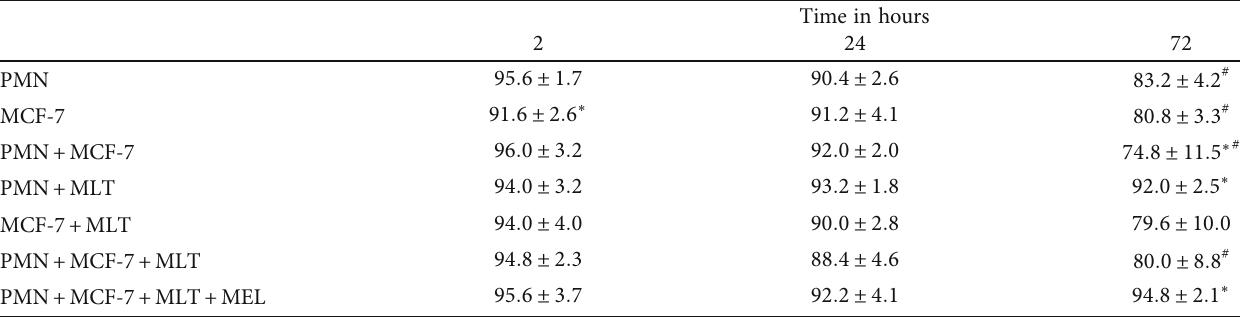
Table 1: Viability index of colostrum polymorphonuclear cells (PMNs) and MCF-7 cells treated or not with melatonin at di ff erent incubation times.